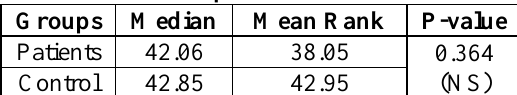
Table 7: The median and mean rank difference of saliva Anti-SSB (ng/ml) in SSc